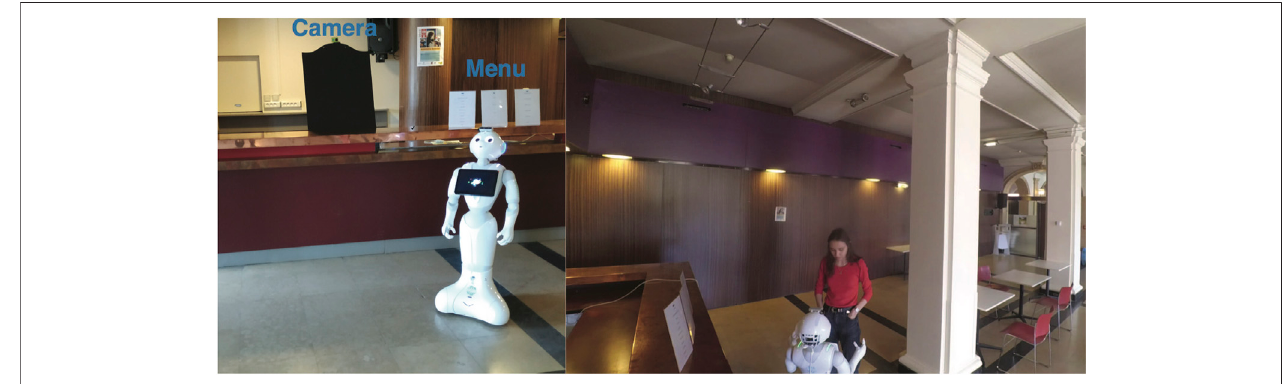
FIGURE 6 | Experiment setup and participant interaction during the barista robot study (Irfan et al., 2020a) at the Cité Internationale Universitaire de Paris (France), with the Adapted Pepper